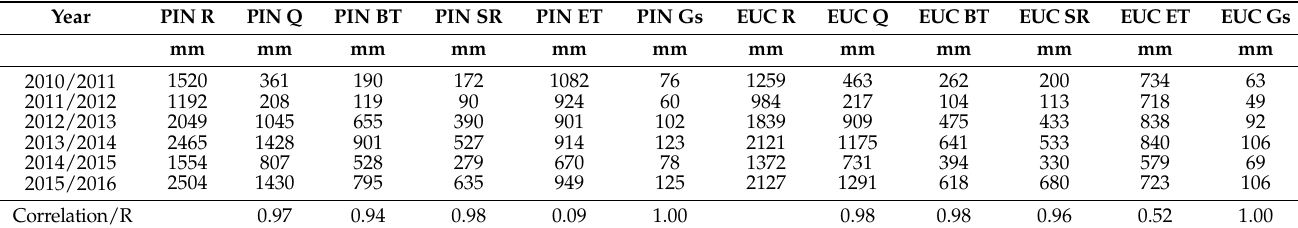
Table 4. Water-balance components in both pine (PIN) and eucalyptus (EUC) catchments, and the correlation coefficient between the different components and